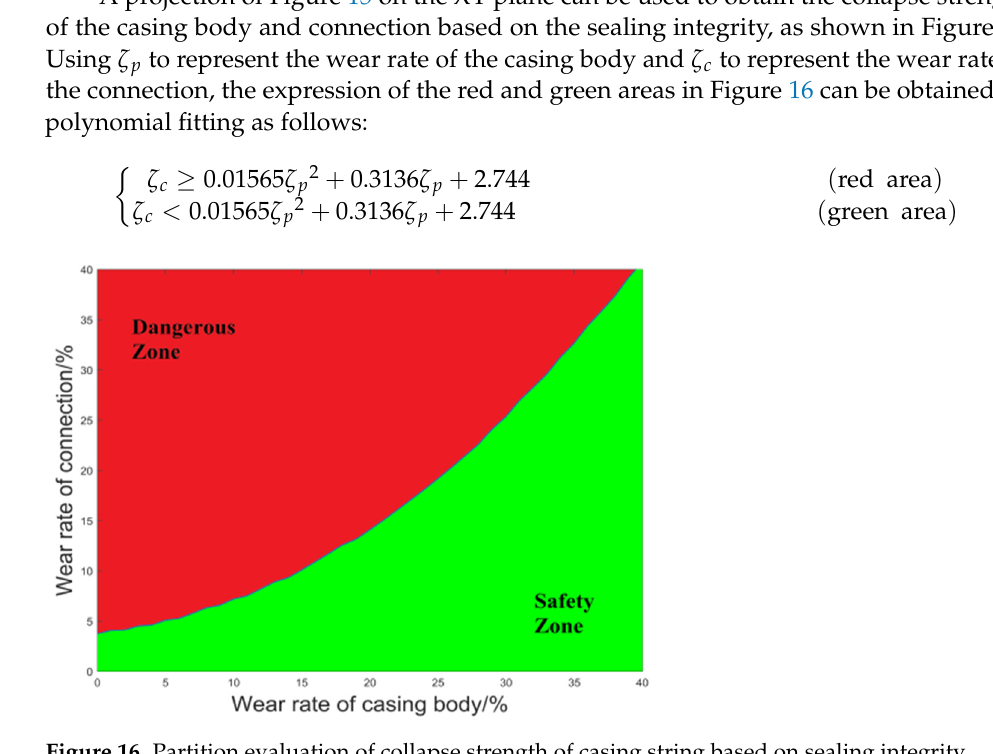
Figure 16. Partition evaluation of collapse strength of casing string based on sealing integrity.